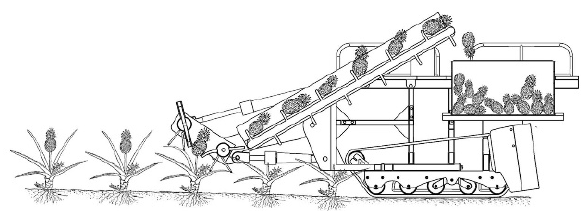
Figure 7. Schematic diagram of pineapple harvest.